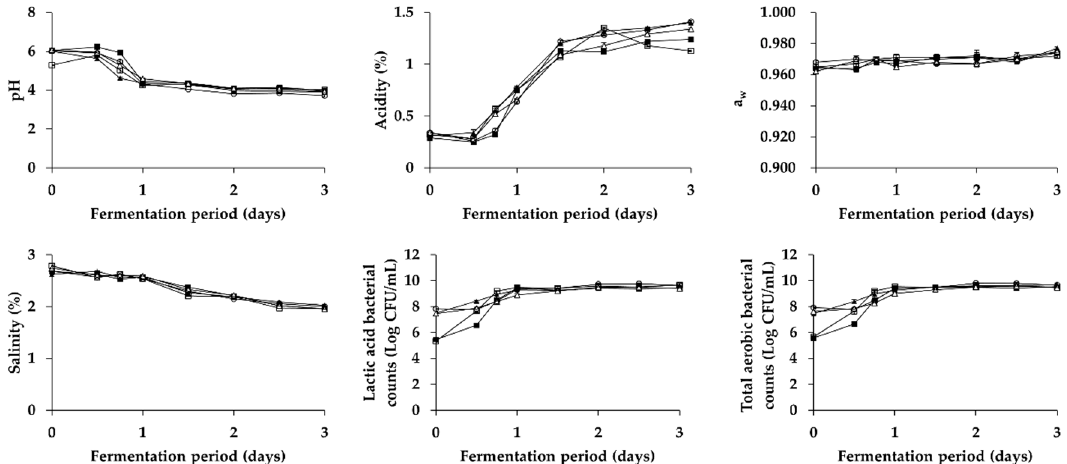
Figure 2. Changes in physicochemical and microbial properties of Chonggak kimchi during fermentation. (cid:3) : B (no addition of Myeolchi-aekjeot and Saeu-jeotgal , no inoculum), (cid:4) : C (addition of Myeolchi-aekjeot and Saeu-jeotgal , no inoculum), (cid:78) : PC (addition of Myeolchi-aekjeot and Saeu-jeotgal , L. brevis JCM 1170), (cid:52) : LB (addition of Myeolchi-aekjeot and Saeu-jeotgal , L. brevis CG2M15), : LP (cid:35) (addition of Myeolchi-aekjeot and Saeu-jeotgal , L. plantarum CG3M21).